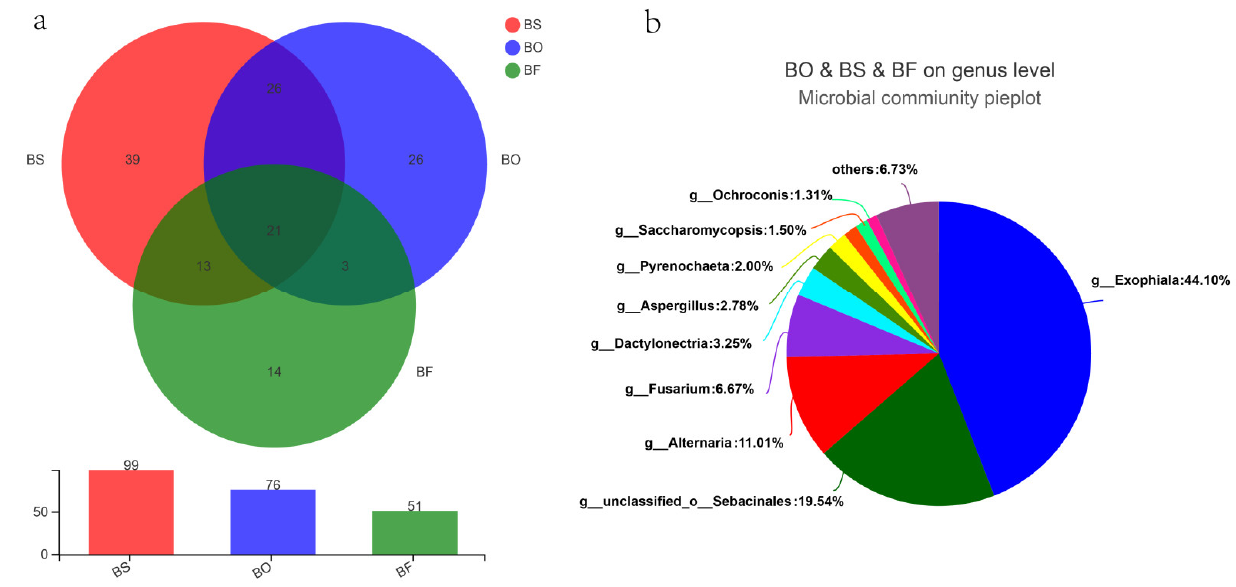
Figure 3. The genus-level composition of root endophytic fungi for three Bletilla species ( a ) and the shared genus among three Bletilla species ( b ). BS, BO, and BF represent B. striata , B. ochracea , and B. formosana , respectively.